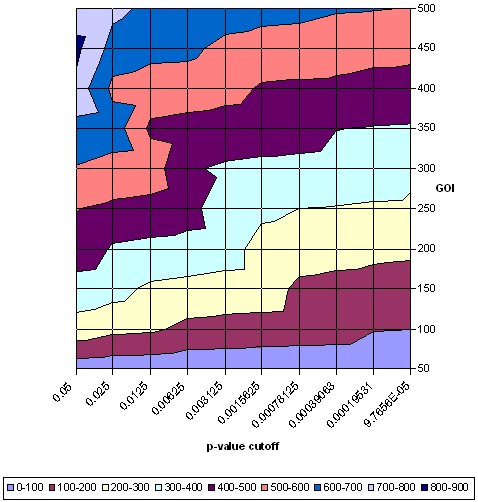
Overhead view of surface topology for the the Arbeitman data set. Different shadings represent different numbers of significant terms.